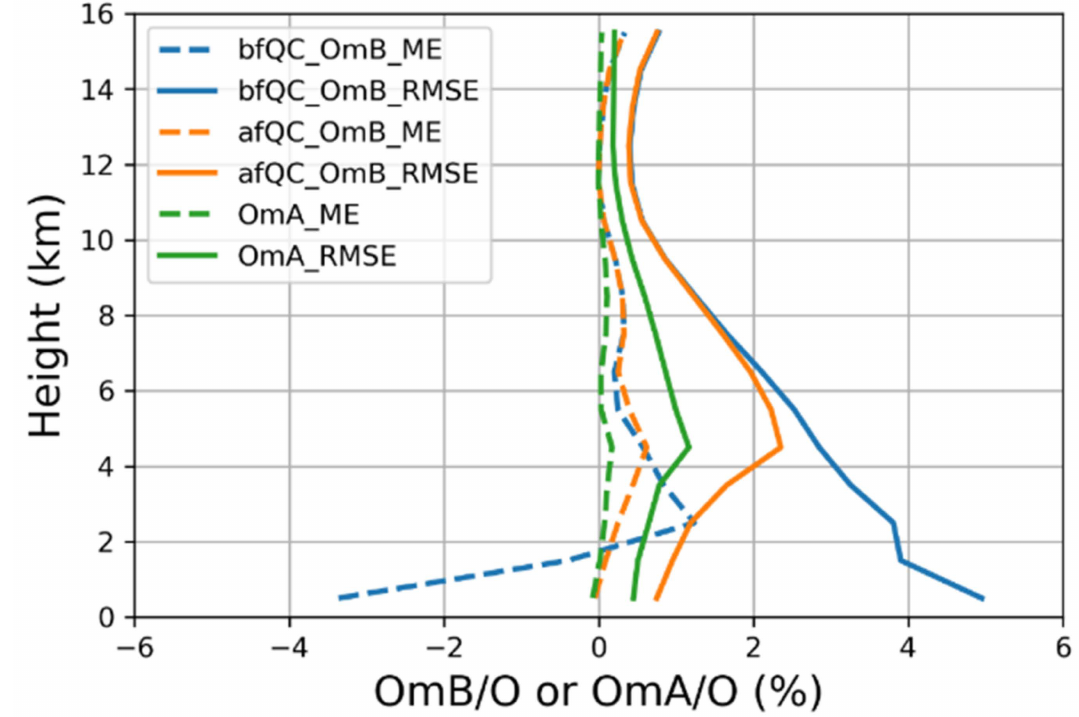
Figure 4. Observation minus background (OmB) and observation minus analysis (OmA) statistics for the FS7 RO refractivity data in wRO experiment. Mean error (ME; dashed lines) and root mean square error (RMSE; lines) of OmB before QC (blue line), OmB after QC (orange line), and OmA after QC (green line) with respect to height (km). The period is the same as that in Figure